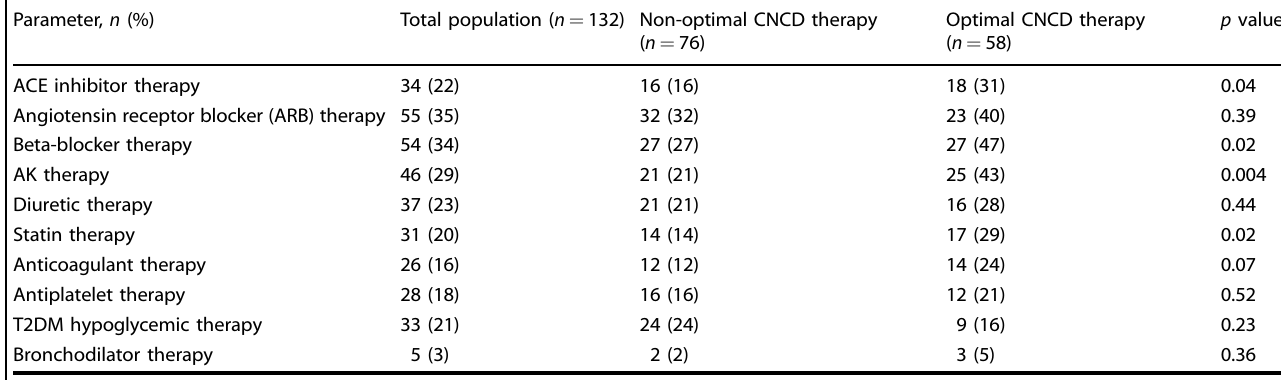
Table 3. Study groups by the preceding CNCD